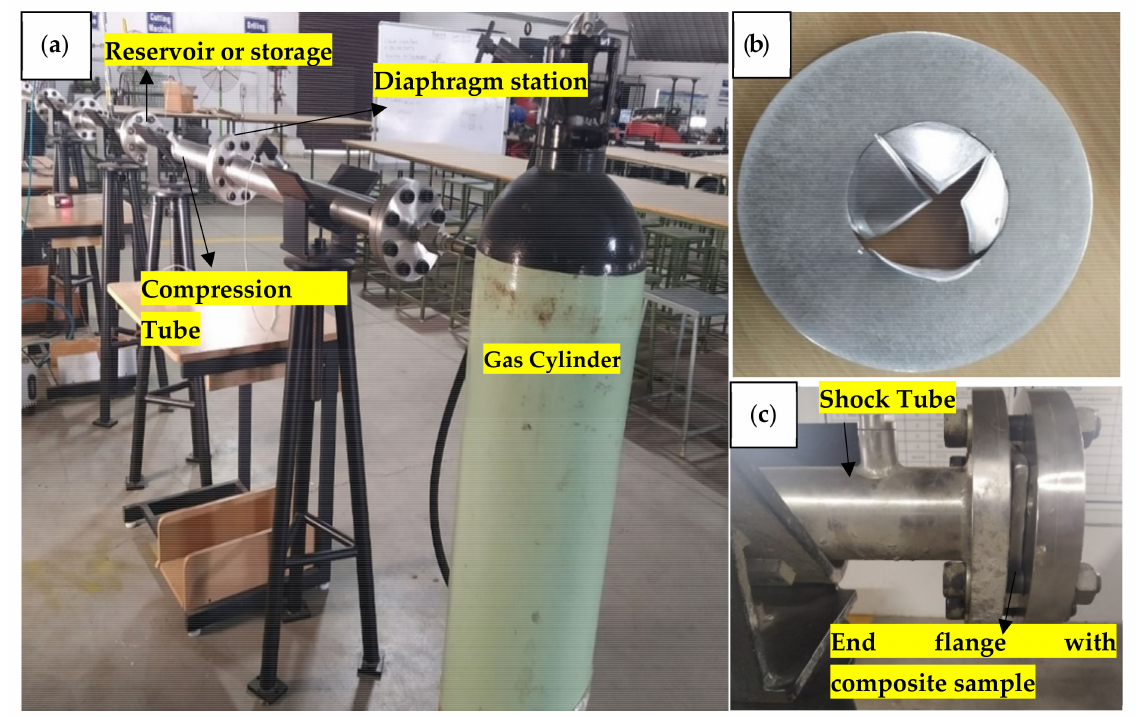
Figure 3. Experimental equipment: ( a ) experimental setup; ( b ) fractured aluminum membrane; ( c ) fixed composite sample.